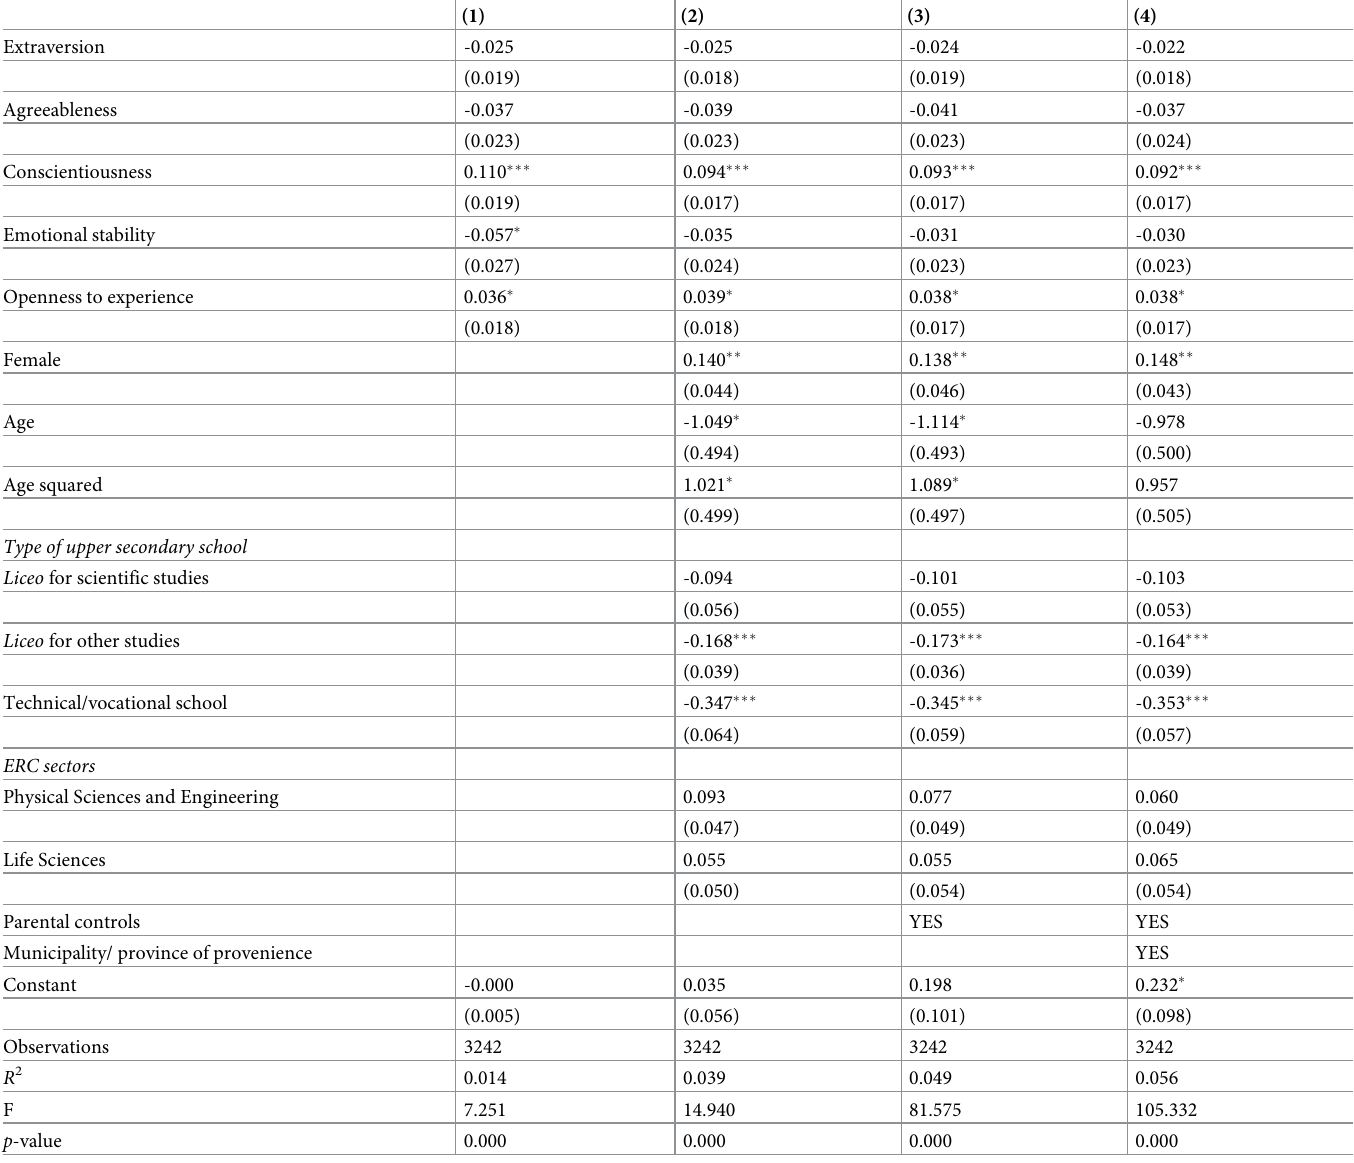
Table 4. Estimated effects of the Big Five personality traits on